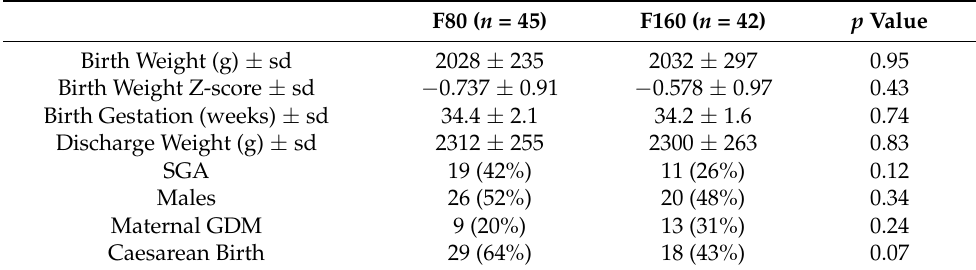
Table 1. Comparative